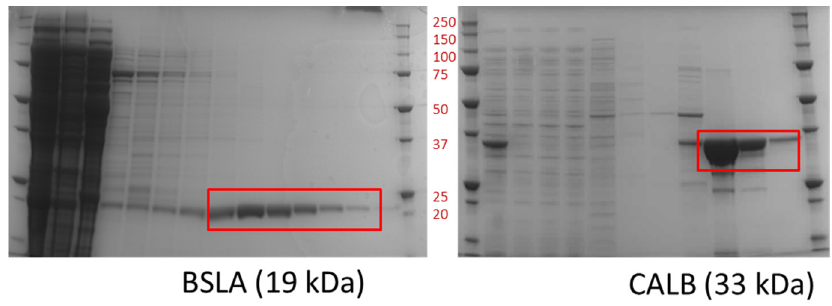
Figure 3. Sodium dodecyl sulfate–polyacrylamide gel electrophoresis (SDS-PAGE) gels of purified BSLA (19 kDa) and Candida antarctica lipase B (CALB) (33 kDa).